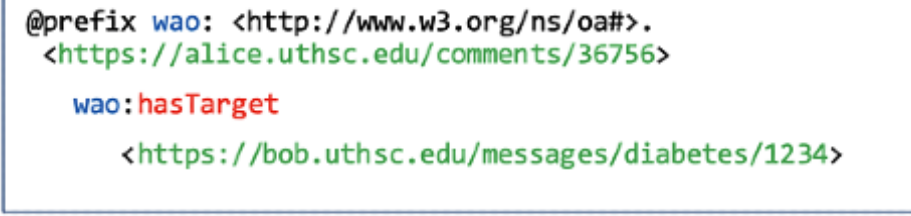
Figure 10. Alice’s comment is linked to Bob’s message using the hasTarget link type of the Web Annotation